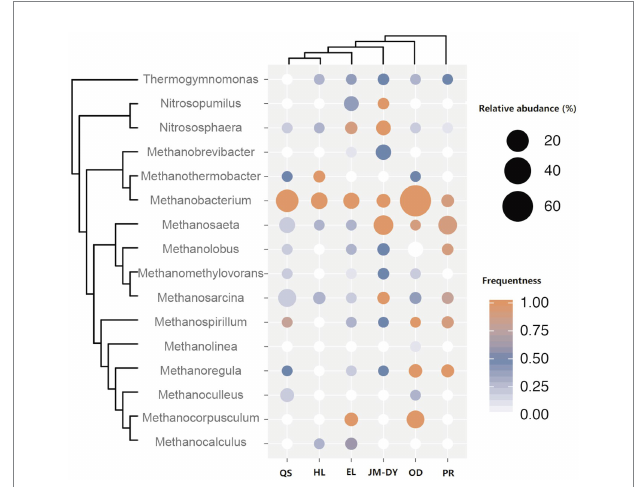
FIGURE 4 Comparative analysis of archaea community structure in coal seams in different basins (QS: Qinshui Basin; HL: Hailar Basin; EL: Erlian Basin; JM-DY: Jingmen-Dangyang Basin; OD: Ordos Basin; PB: Powder river Basin). The size of the bubble represents the relative abundance of the genus in each sample. The change in bubble color represents the frequency of the genus